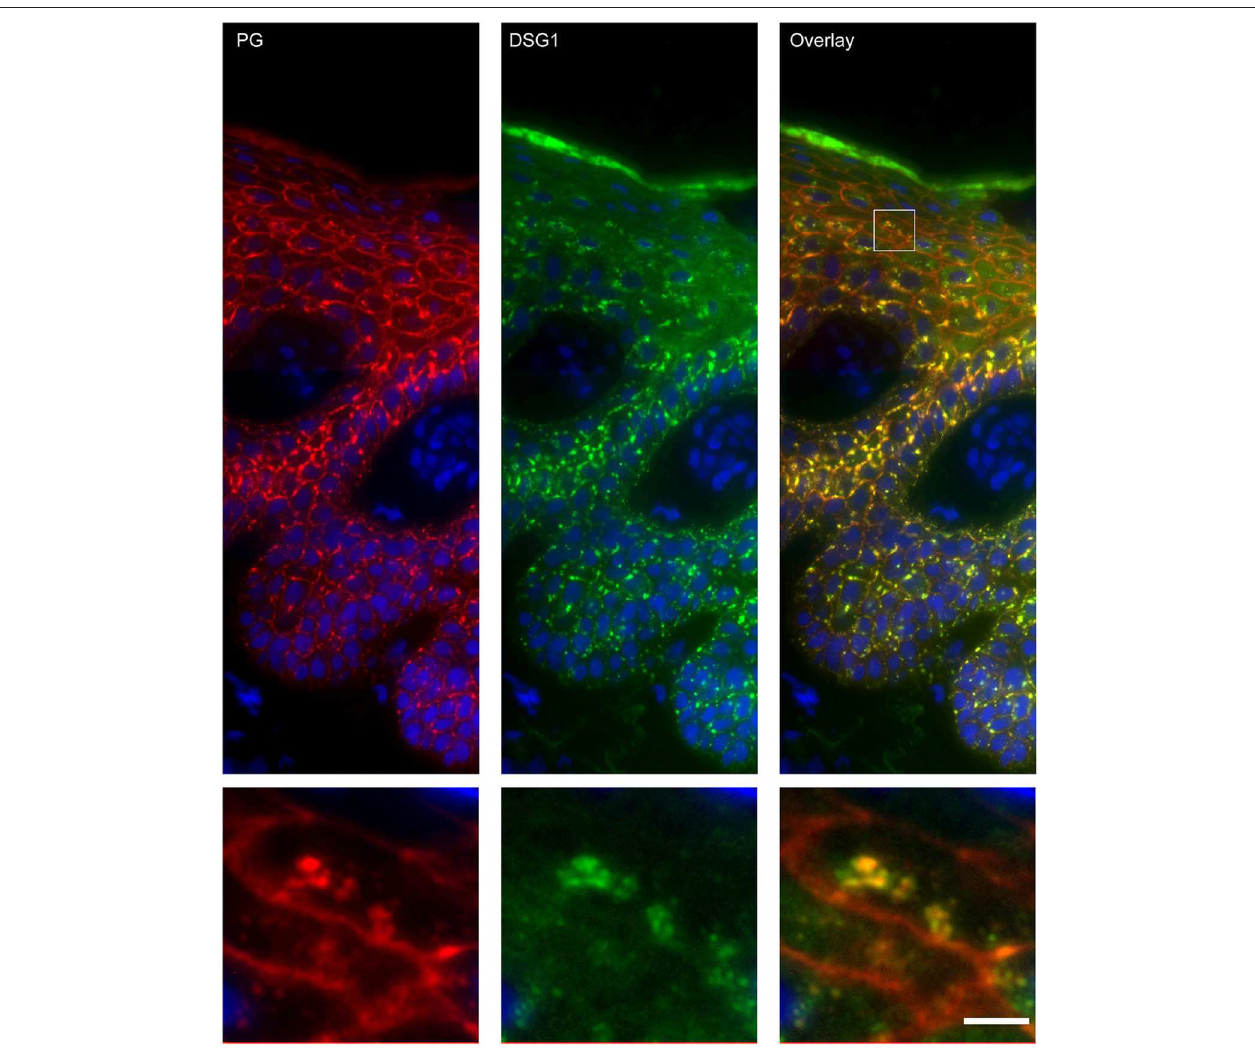
FIGURE 4 | Double staining of desmoglein 1 and plakoglobin 1 shows that these are both present in the endosomes. The upper panel shows the overview, the lower panel shows the detail from the white box in the upper panel. White bar is 5 µ m.